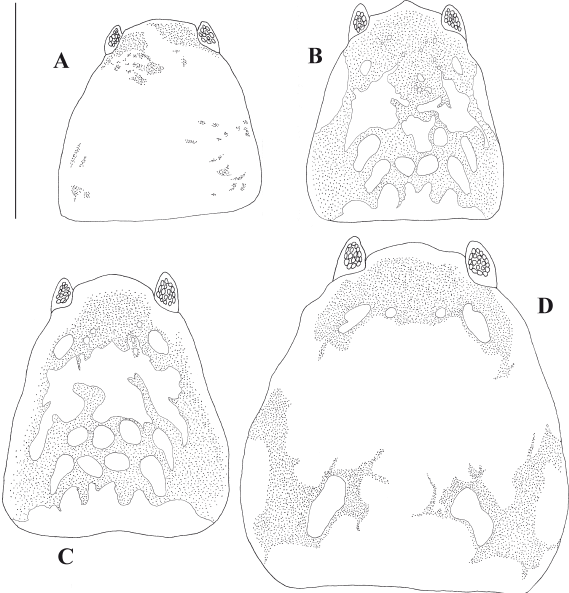
Fig. 5. – Pigmentation of carapace. Zeuxo exsargasso . A, Gran Ca- naria, type 1. B, Gran Canaria, type 2. C, Cape Verde, type 1. D, Cape Verde, type 2. Scale bars, 0.5